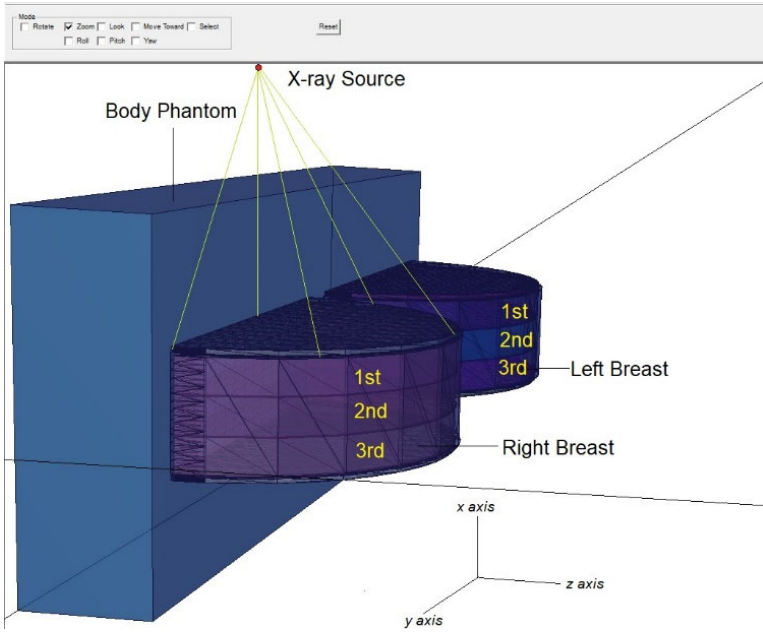
Figure 2. Three ‐ dimensional view of modelled breast phantom and breast layers in MCNPX code. Figure 2. Three-dimensional view of modelled breast phantom and breast layers in MCNPX code.